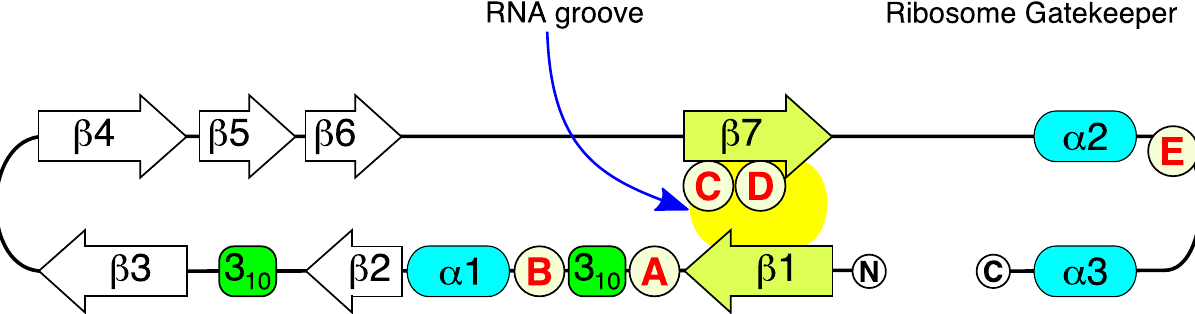
Figure 2. Secondary structure of Nsp1. Schematic diagram depicting the secondary structure of Nsp1 represented as an unfolded chain (from N- to C-terminal) with numbered alpha helices (α), numbered beta sheets (β), and 3 10 helices. The beta sheets, β2 pairs with β6, β3 pairs with β4, and β1 pairs with β7 to form an RNA groove. The C-terminal helix-loop-helix (α2-α3) is termed the ribosome gatekeeper 13 because of its role in blocking the RNA tunnel in the 40S ribosomal subunit. The sequential order and beta sheet pairings were adapted from Semper et al. 18 and Almeida et al. 19 . The mutations depicted are ( A ) (L21M), ( B ) (D33R), ( C ) (L123S/R124E), ( D ) (N128S/K129E), and ( E )